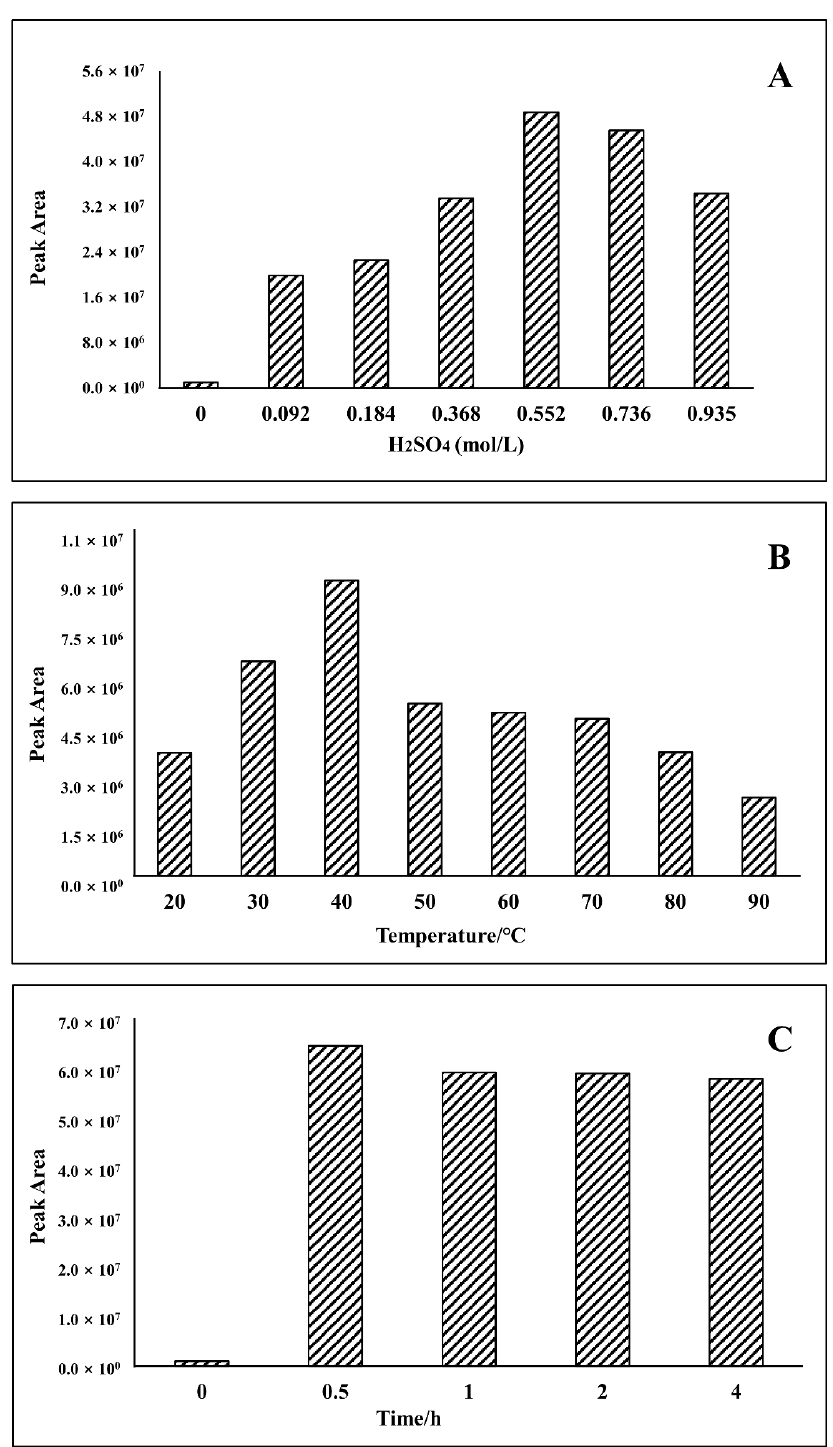
Figure 3. Effect of acid hydrolysis conditions. ( A ) Effect of H 2 SO 4 concentration; ( B ) Effect of acid hydrolysis temperature; ( C ) Effect of acid hydrolysis time.